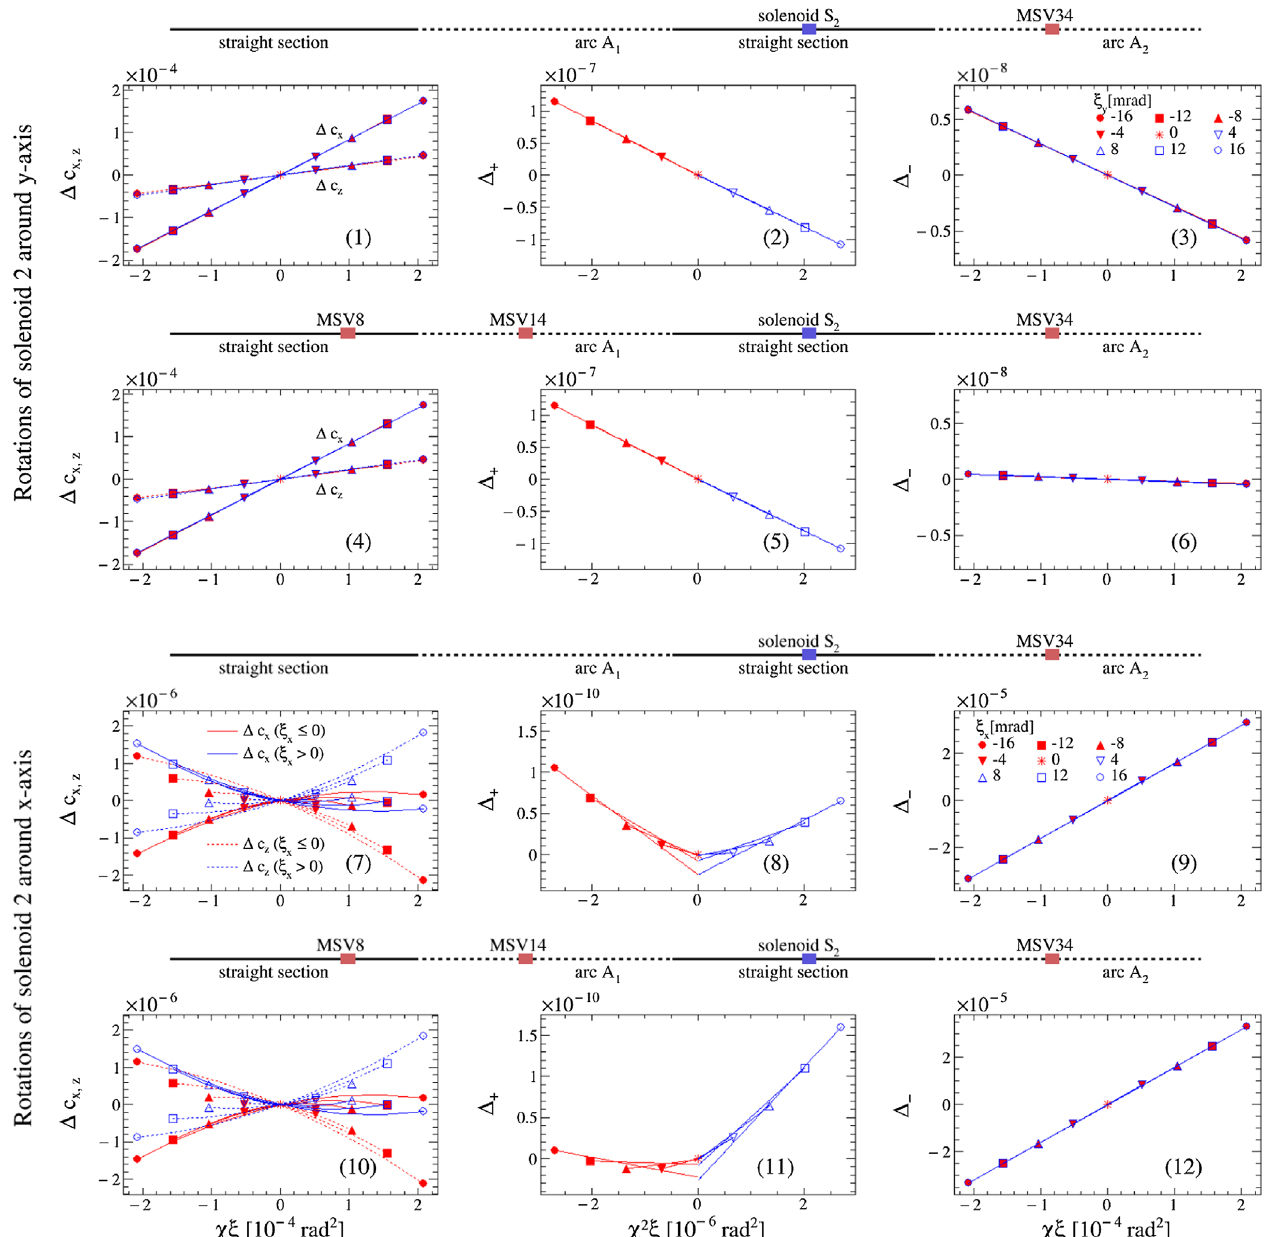
FIG. 10. Perturbation of the spin transfer matrix t [see Eq. (58)] due to closed orbit excursions (see Fig. 8) by the steering fields of the R misaligned solenoid S 2 . Panels 1 – 6 show the effect of rotations of solenoid S 2 around the y -axis. The first row of panels 1 – 3 shows Δ c ξ ; χ [Eq. (64)], and Δ ð ξ ; χ AI Þ [Eq. (65)] for orbit set 1 (Table III). The second row of panels 4 – 6 show the same parameters for x;z ð AI Þ (cid:3) orbit set 2. The corresponding situation for rotations of S 2 around the x -axis is depicted in panels 7 – 12. Note that in order to emphasize the different scaling properties, Δ c (first column of panels) and Δ − (third column) are plotted as a function of the variable χξ , while Δ x;z (second column) is plotted as a function of the variable χ 2 ξ . To avoid overcrowding of data points, for each ξ only the end point results at χ 12 . 98 mrad are shown. In panels 1 to 6, 9 and 12, the points for all ξ fall on the same straight line. In panels 7, 8, 10, and 11, the AI ¼ (cid:3) actual dependence on χ is shown by the curves drawn to guide the eye (see text for more AI